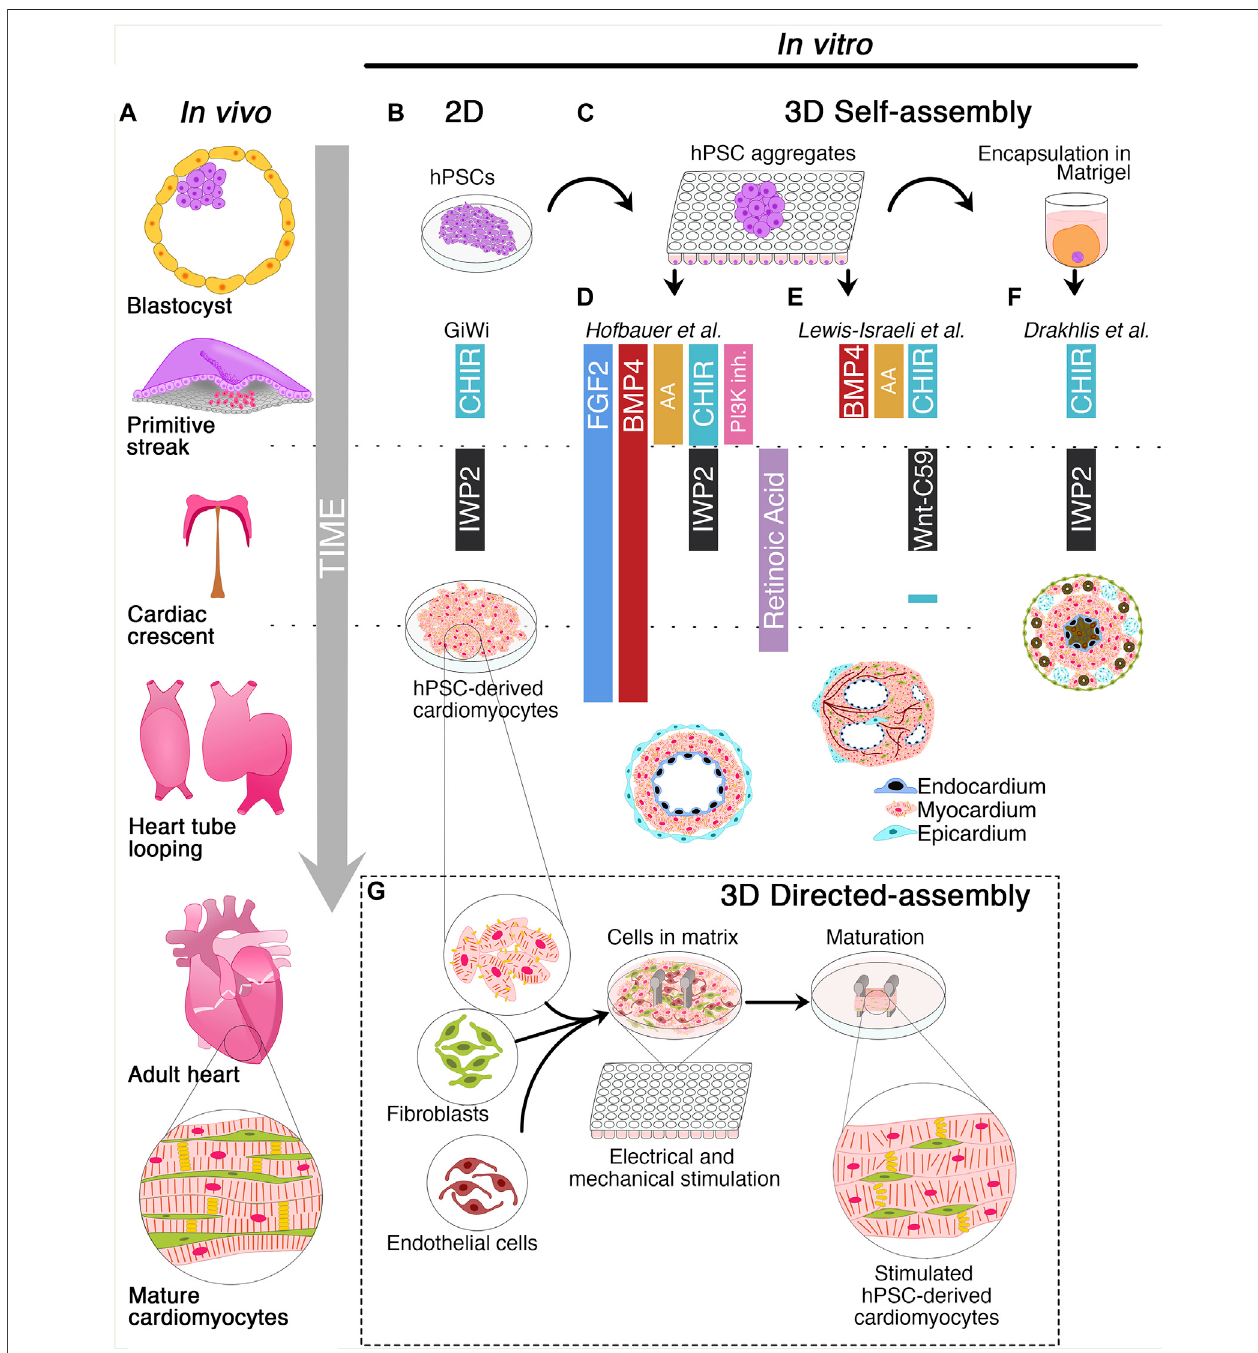
FIGURE 1 | Schematic of cardiac development and 2D/3D culture methods for the derivation of human cardiac organoids. (A) Timeline of cardiac development in vivo .Theblastocystoriginatestheprimitivestreakfromwhichthemesodermallayeremerges.Cardiovascularprogenitorsmigratethroughtheprimitivestreaktoformthe cardiac crescent at the embryo ’ s midline and generate the heart tube. Subsequently, heart tube looping and remodeling produce the fi nal heart architecture. (B) Description of 2D GiWi differentiation protocol. hPSCs are treated with CHIR99021 (GSK3 inhibitor/Wnt activator) to induce primitive streak and mesoderm, followedbyIWP2(Wnt-inhibitor)treatmenttotriggerthecardiaccommitment.TheGiWi2Dprotocolgeneratesimmaturefetal-likehPSC-derivedcardiomyocytes. (C) 3D self-assembly of human cardiac organoids begins with hPSCs aggregation in ultra-low attachment plates. However, only Drakhlis et al. used an additional hPSC aggregate encapsulation in Matrigel. (D) Hofbauer et al. implemented FGF2 and BMP4 throughout the mesoderm induction, cardiac mesoderm, and cardiomyocyte speci fi cation. Additionally, this method relies on Activin A (AA), CHIR99021, and LY294002 (PI3K- inhibitor) for mesoderm induction, IWP2, and retinoic acid for cardiac mesoderm induction. Additional co-culture with epicardial aggregates generates hCOs with chamber-like structures and three layers composed of epicardium,